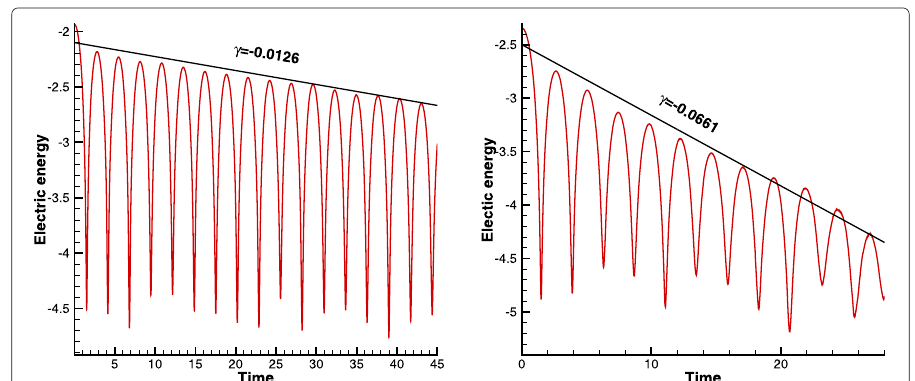
Fig. 3 Results of Landau damping. Red line shows the time evolution of the electric energy calculated by the UGKWP method, and the black lines give the theoretical prediction of the electric energy decay rate